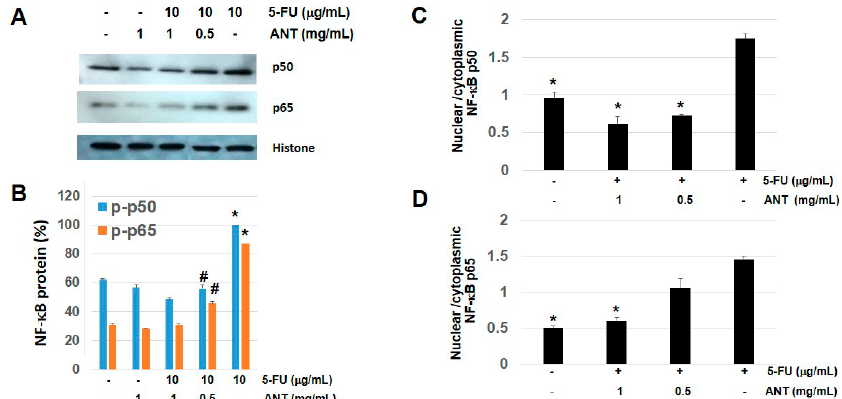
Figure 8. Effects of ANT-rich extract on 5-FU-induced NF- κ B phosphorylation. ( A ) Oral keratinocytes were stimulated with 5-FU in the presence or absence of ANT-rich extract for 1 h. Western blotting was performed for nuclear fraction of NF- κ B p50 and p65, with histone as an equal loading control. The blots shown are representative of data from at least three experiments; ( B ) Quantifying nuclear NF- κ B p 50 and p65 levels; data are expressed as the mean ± S.D. * p < 0.01 vs. control, # p < 0.05 vs. 1